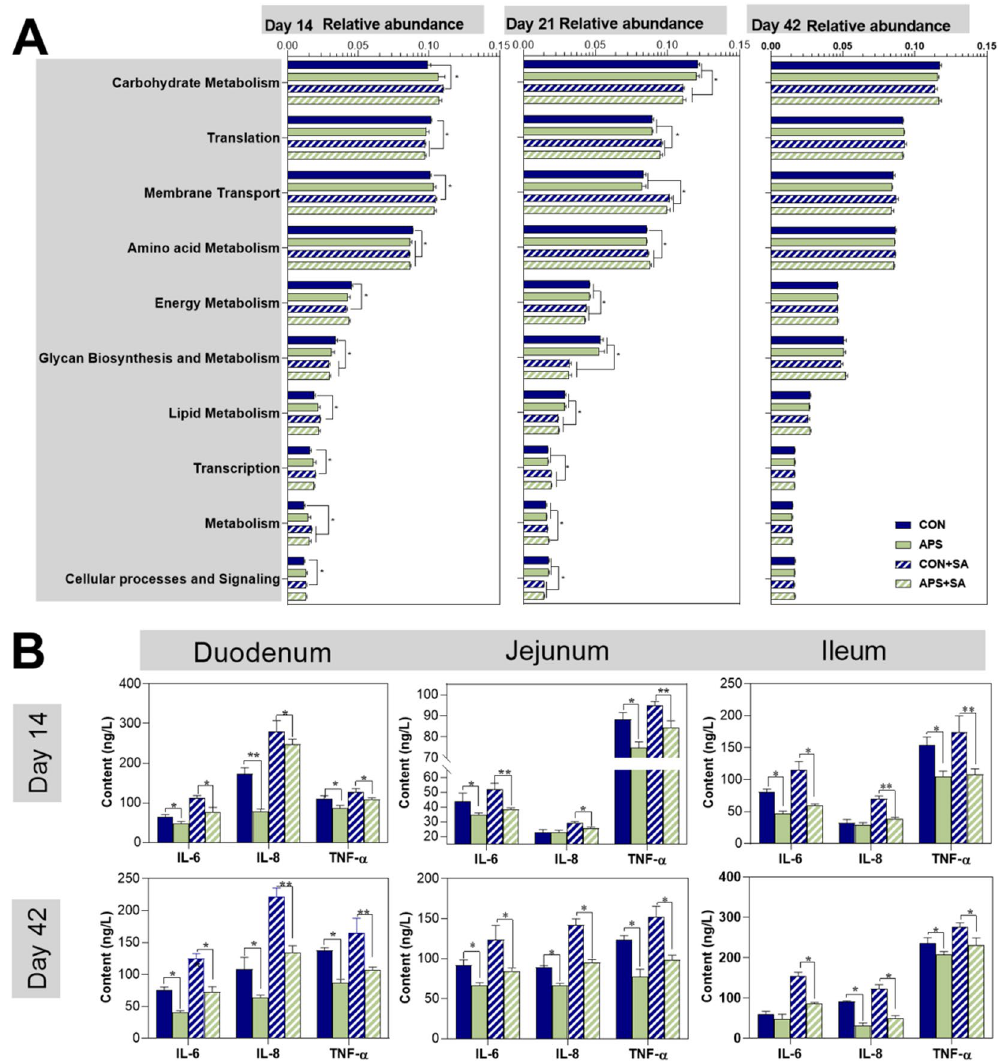
Figure 5. Effects of dietary APS supplementation on the functional genes abundance and inflammatory cytokines of S. ser. Enteritidis -infected broilers. ( A ) Abundance of certain functional genes related to metabolism or signaling pathways, ( B ) the expression of some inflammatory cytokines. CON, control pair-fed group; APS, APS-supplemented pair-fed group; CON + SA, control S. ser. Enteritidis -challenged group; APS + SA, APS- supplemented and S. ser. Enteritidis -challenged group. n =